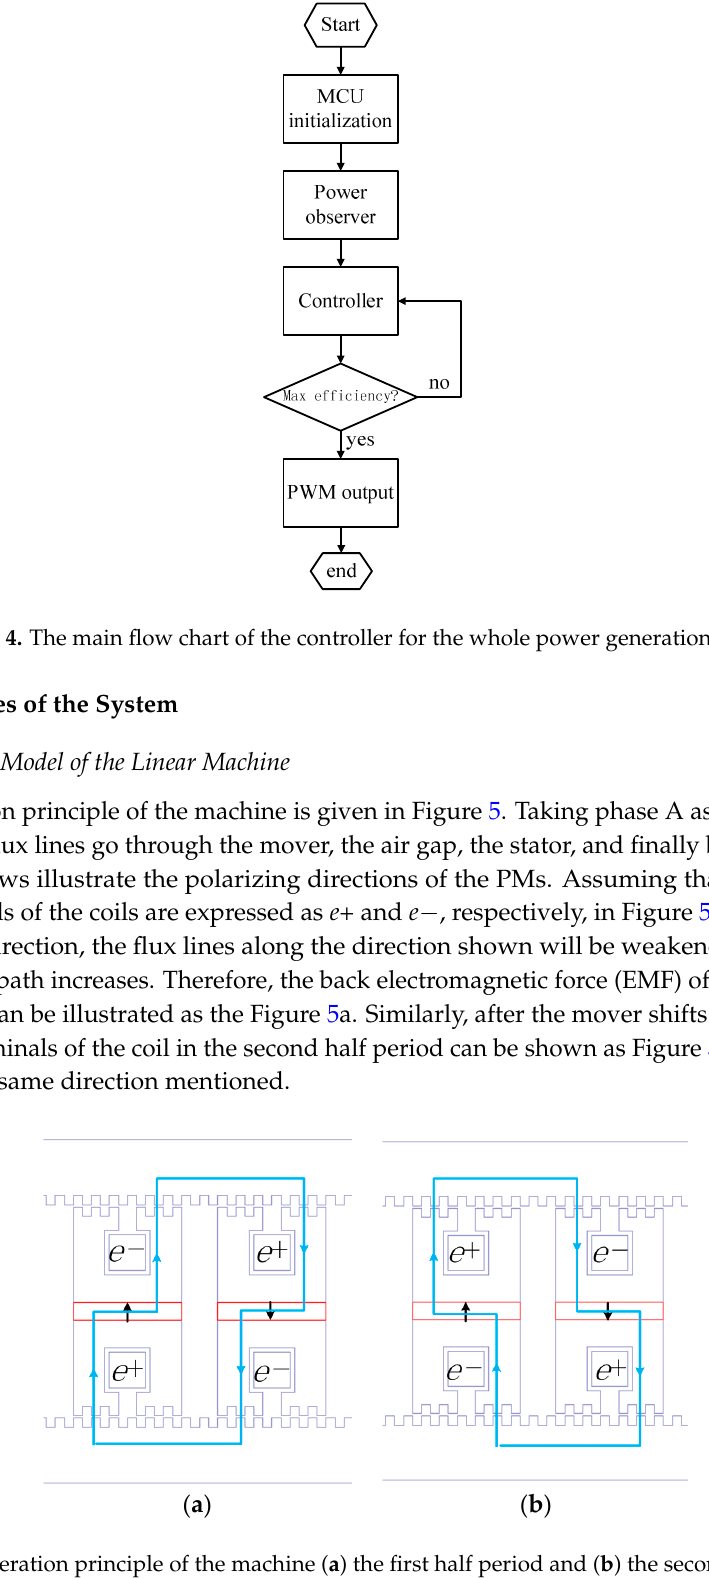
Figure 3. Topology of the power generation and storage system.